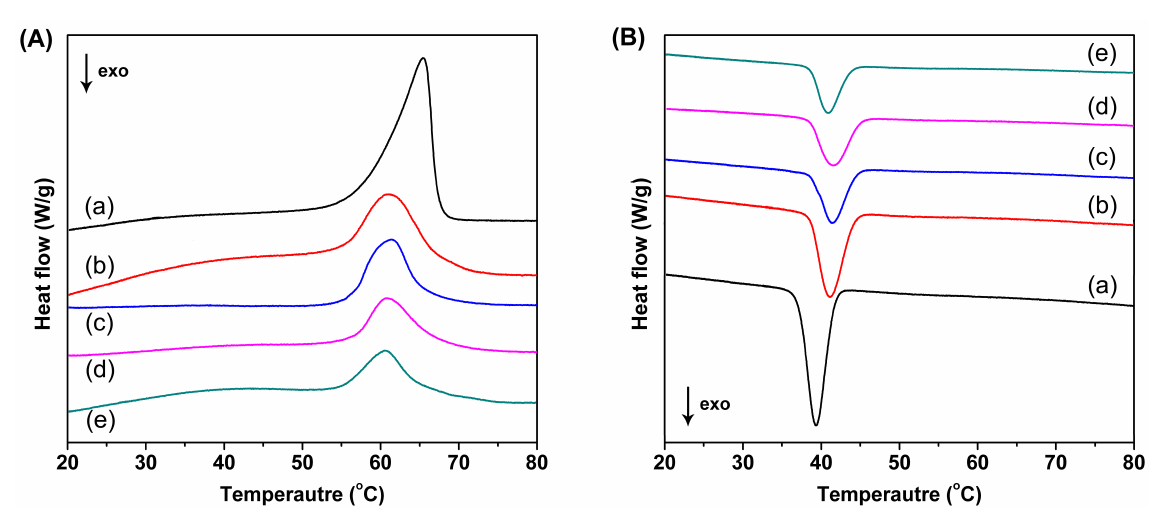
Figure 3: DSC thermograms of nanofibers for the melting cycle (A) and cooling cycle (B). (a) neat PCL; (b) PCL/CB[7] (100:50); (c) PCL/CB[7] (100:100); (d) PCL/CB[7] (100:150); (e) PCL/CB[7] (100:200).